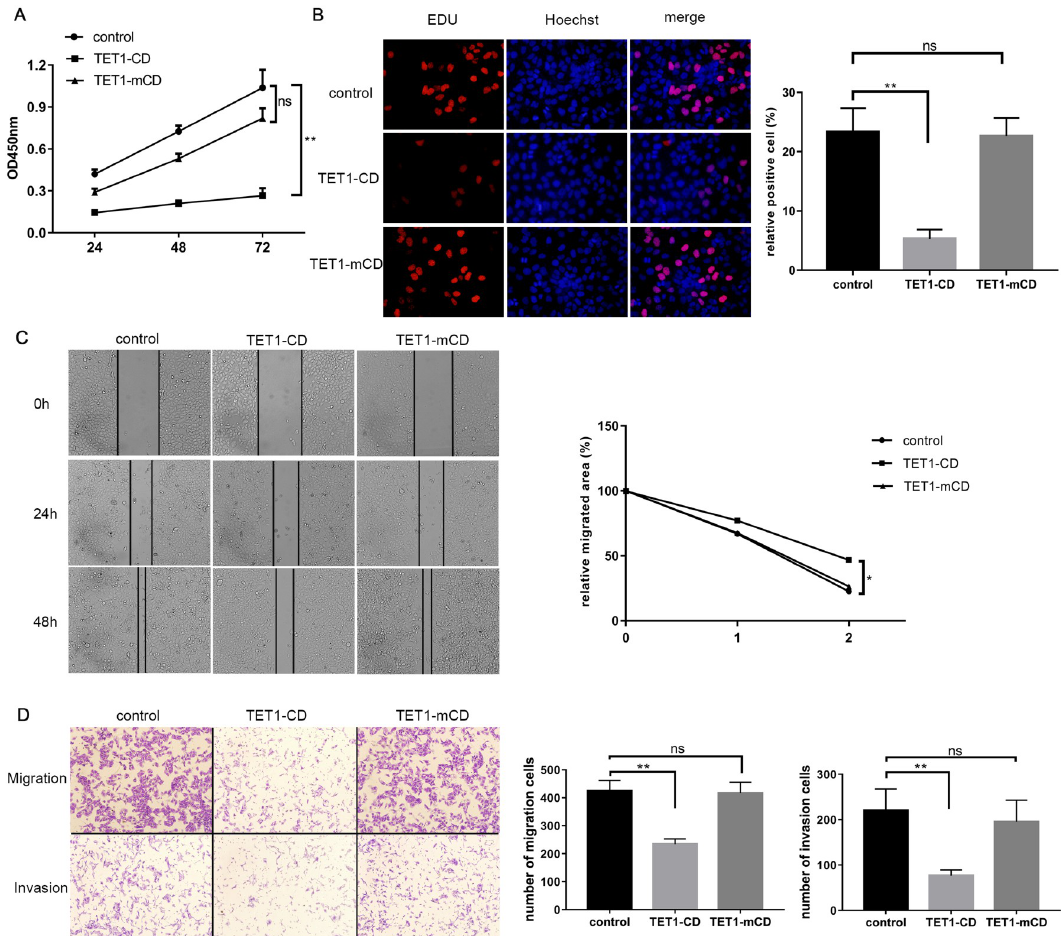
Fig 3. TET1-CD inhibits proliferation, migration and invasion of the SMMC 7721 cells. (A). After transfection of empty vector, TET1-CD and TET1-mCD plasmids into the SMMC 7721 cells respectively for 24h, 48h and 72h, and incubation of these cells with CCK-8 solution at 37˚C for 1 h, the absorbance of these cells at 450 nm was measured to assess their proliferation. (B). The SMMC 7721 cells were inoculated into the 24-well plate, and fluorescence staining was performed 48h after inoculation. (C). Microscopy was used to capture the cell scratched area at 0h, 24h and 48h. (D). The cells, which migrated from the upper chamber to the lower chamber, were counted to assess their migration and invasion ability. The results were represented as mean ± SD of three independent experiments. One-way ANOVA, � p < 0.05 and �� p <